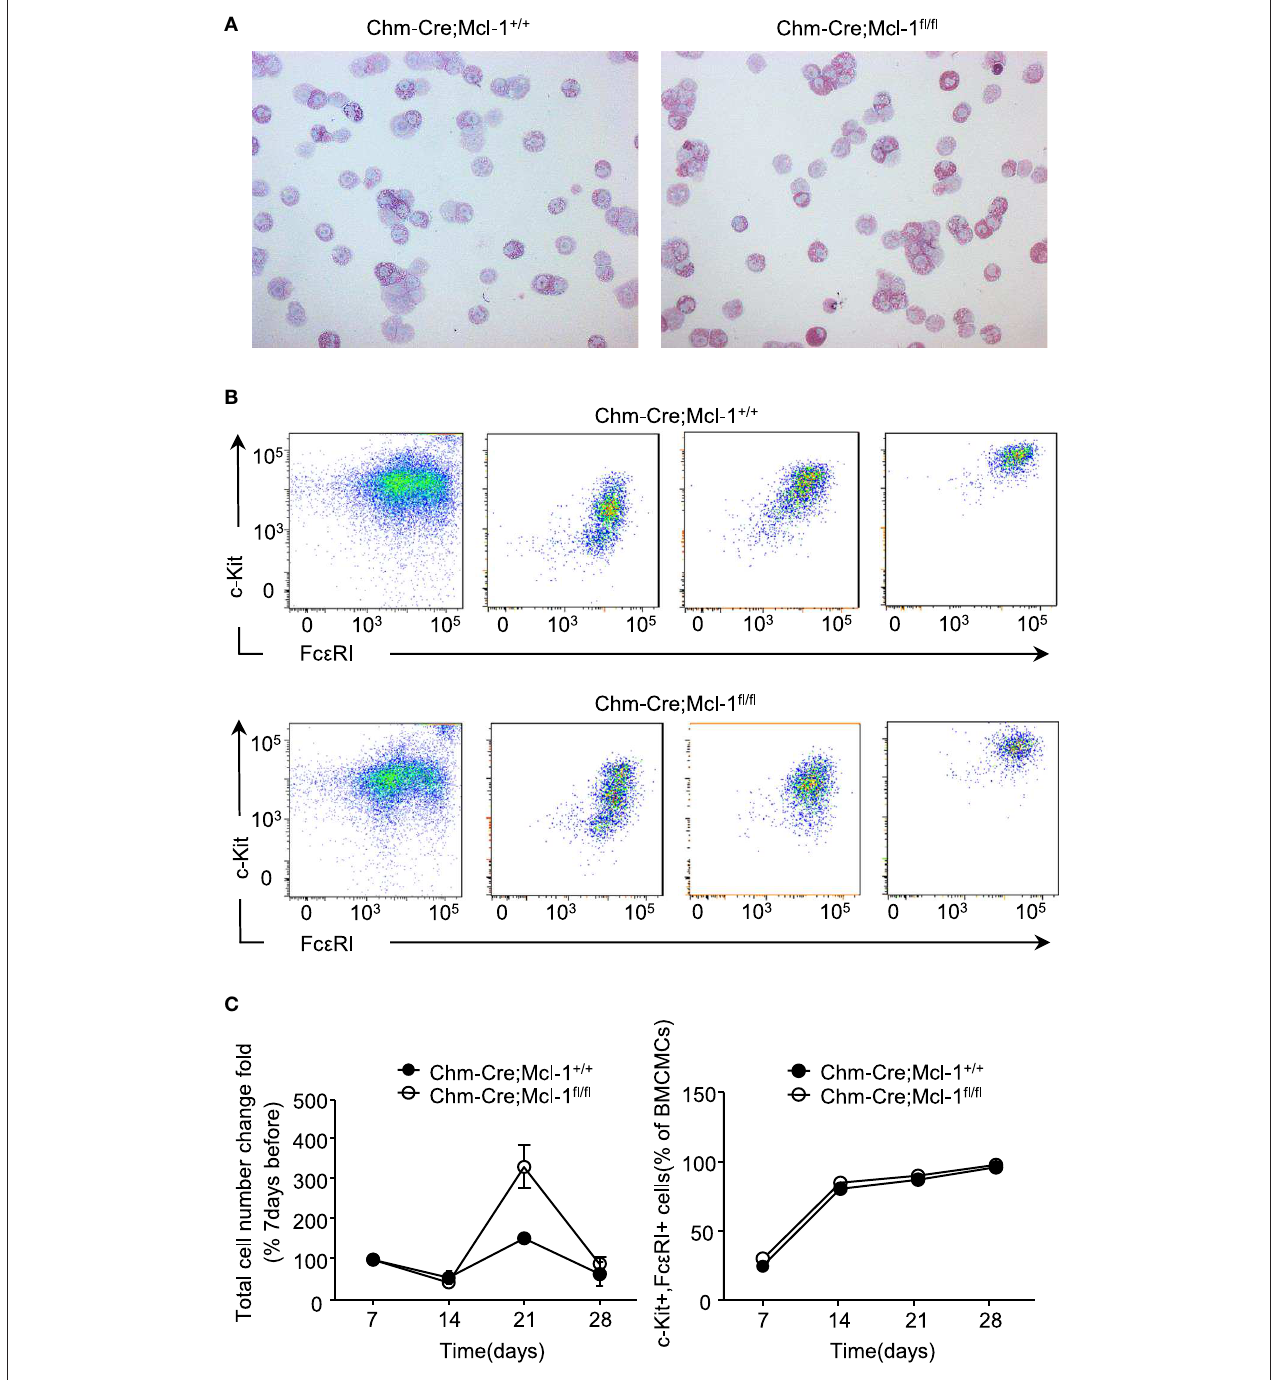
FIGURE 5 | Comparable proliferation and differentiation rates in bone marrow-derived cultured mast cells (BMCMCs). (A) Representative light micrograph shows comparable morphology of BMCMCs after 4 weeks of culture in IL-3-supplemented medium from Chm-Cre; Mcl-1 + / + control mice and Chm-Cre; Mcl-1 fl / fl mice. BMCMCs were identified morphologically on cytospin cell preparations stained with Giemsa solution. (B) Representative flow cytometry plots and percentage of c-kit and Fc ε RI expression show comparable differentiation rate on BMCMCs isolated from Chm-Cre; Mcl-1 + / + mice and Chm-Cre;Mcl-1 fl / fl mice after 7, 14, 21, and 28 days of culture. (C) The proliferation rate of BMCMCs was evaluated by calculating the fold change of cell number over time. Data show similar proliferation rates of BMCMCs after 7, 14, 21, and 28 days of culture from Chm-Cre; Mcl-1 + / + mice and Chm-Cre; Mcl-1 fl / fl mice. (A) 200 × magnification. Data are pooled from three independent experiments ( n = 3 mice per group ±